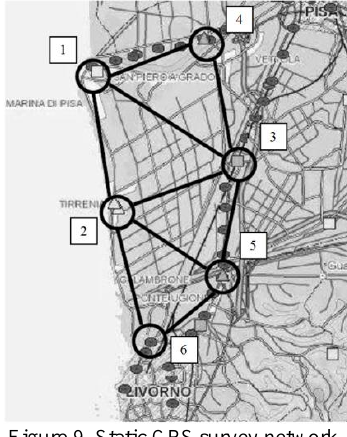
Figure 9. Static GPS survey network